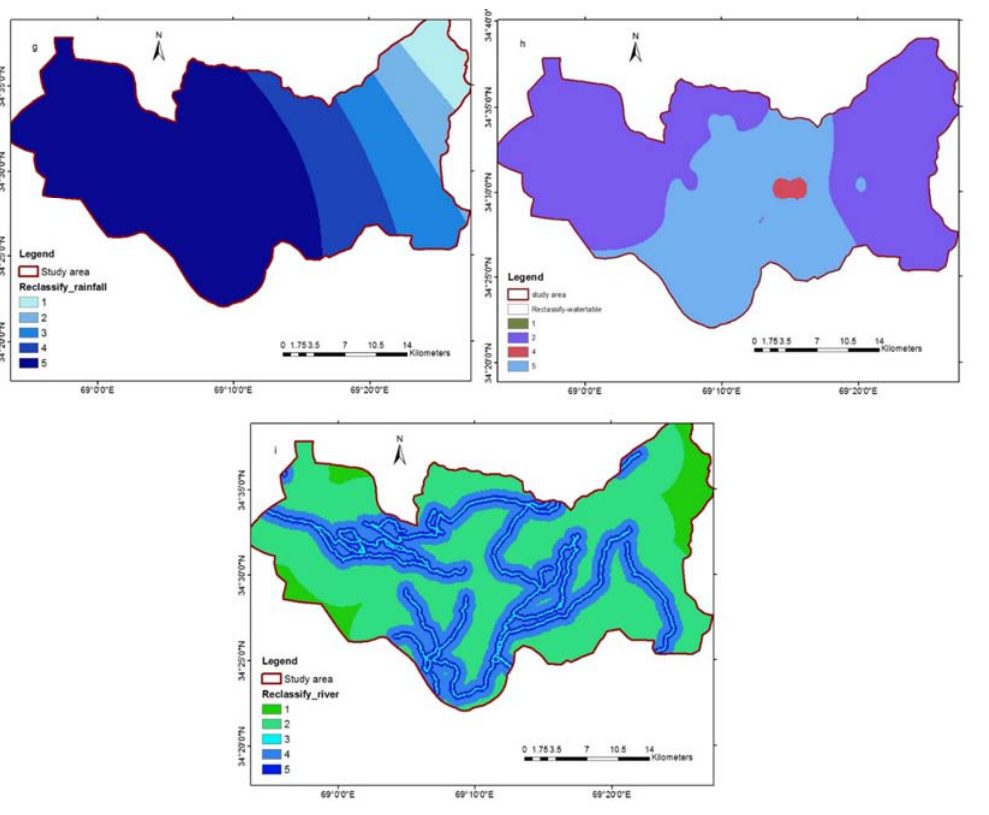
Figure 7. Ranked and reclassified layer maps: ( a ) slope; ( b ) drainage density; ( c ) distance to fault; ( d ) land use; ( e ) lithology; ( f ) soil texture; ( g ) rainfall; ( h ) water table; ( i ) distance to river.